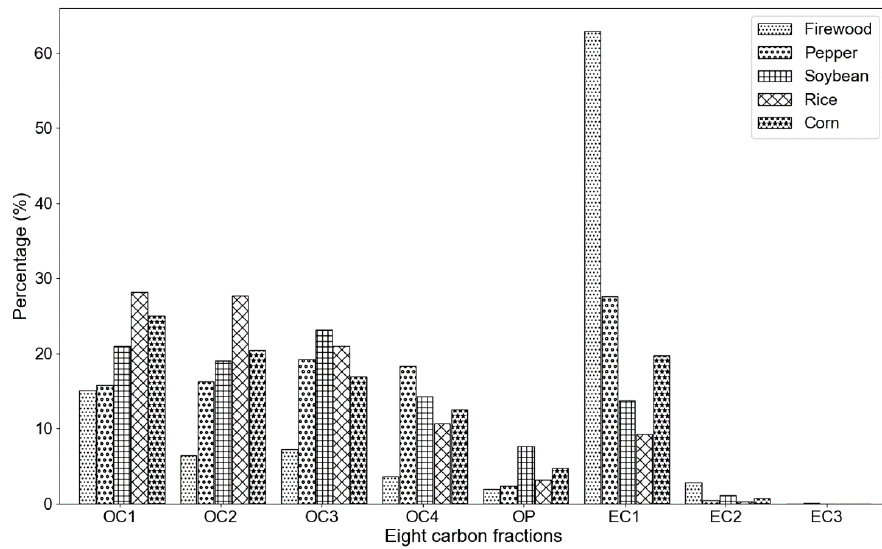
Figure 4. Average percentages of eight carbon fractions in the biomass burning samples.